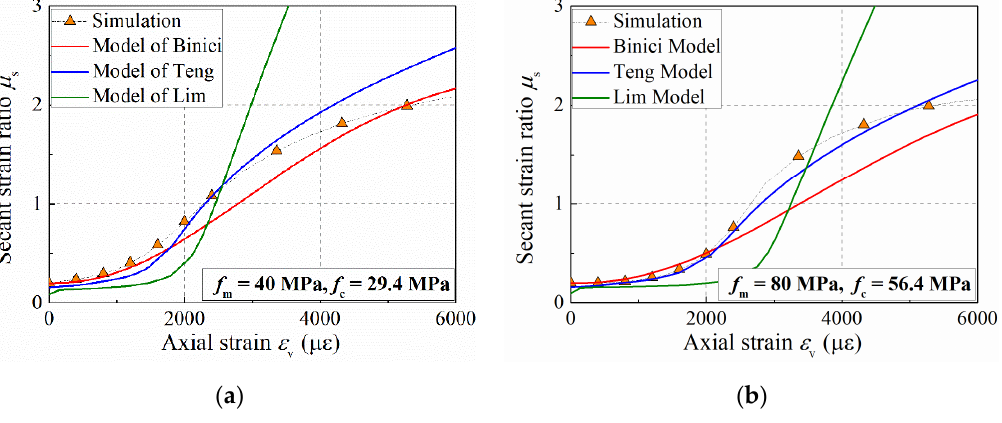
Figure 12. The secant strain ratio–strain relationship: ( a ) f m = 40 MPa; ( b ) f m = 80